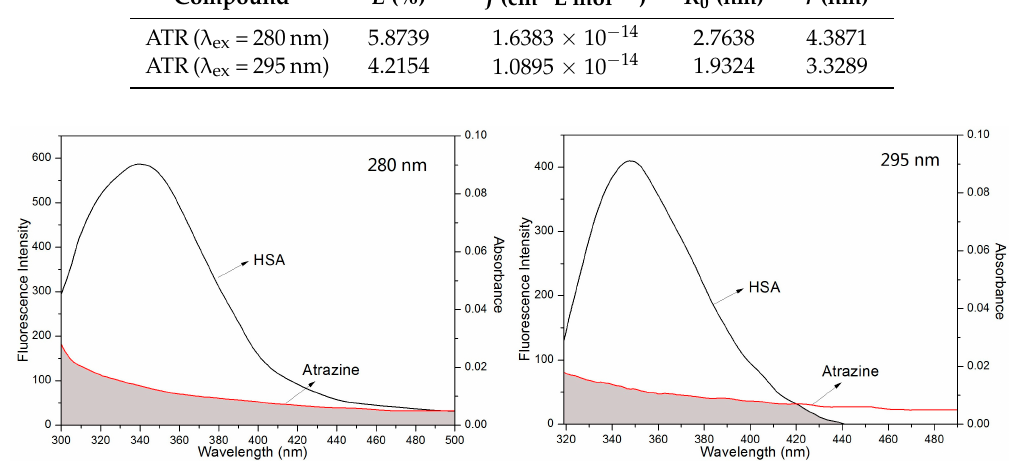
Table 4. Parameters of E , J , R 0 and r of ATR-HSA system.